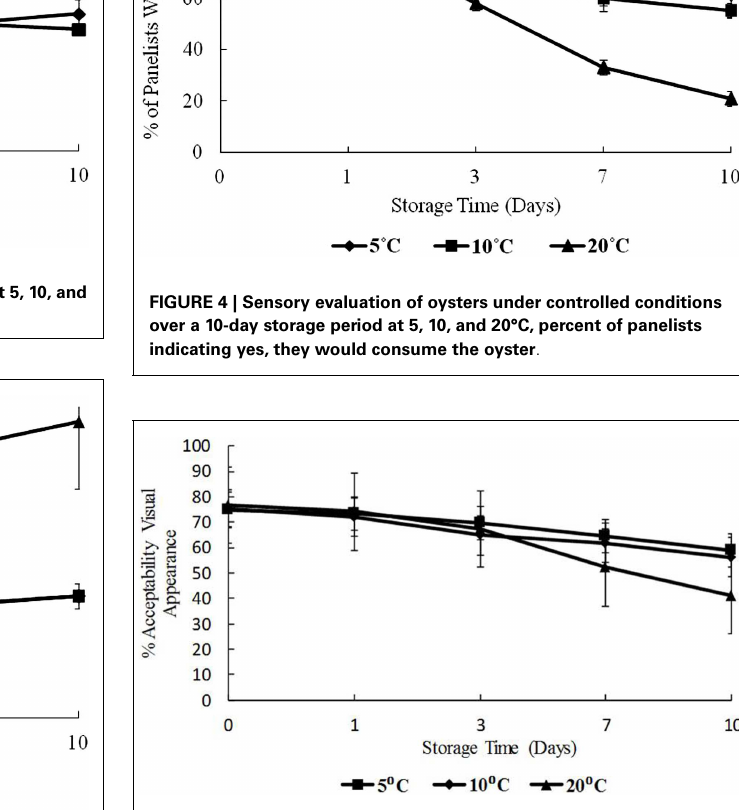
FIGURE 3 | Levels of Vibrio parahaemolyticus during 10days of storage at 5, 10, and 20°C .